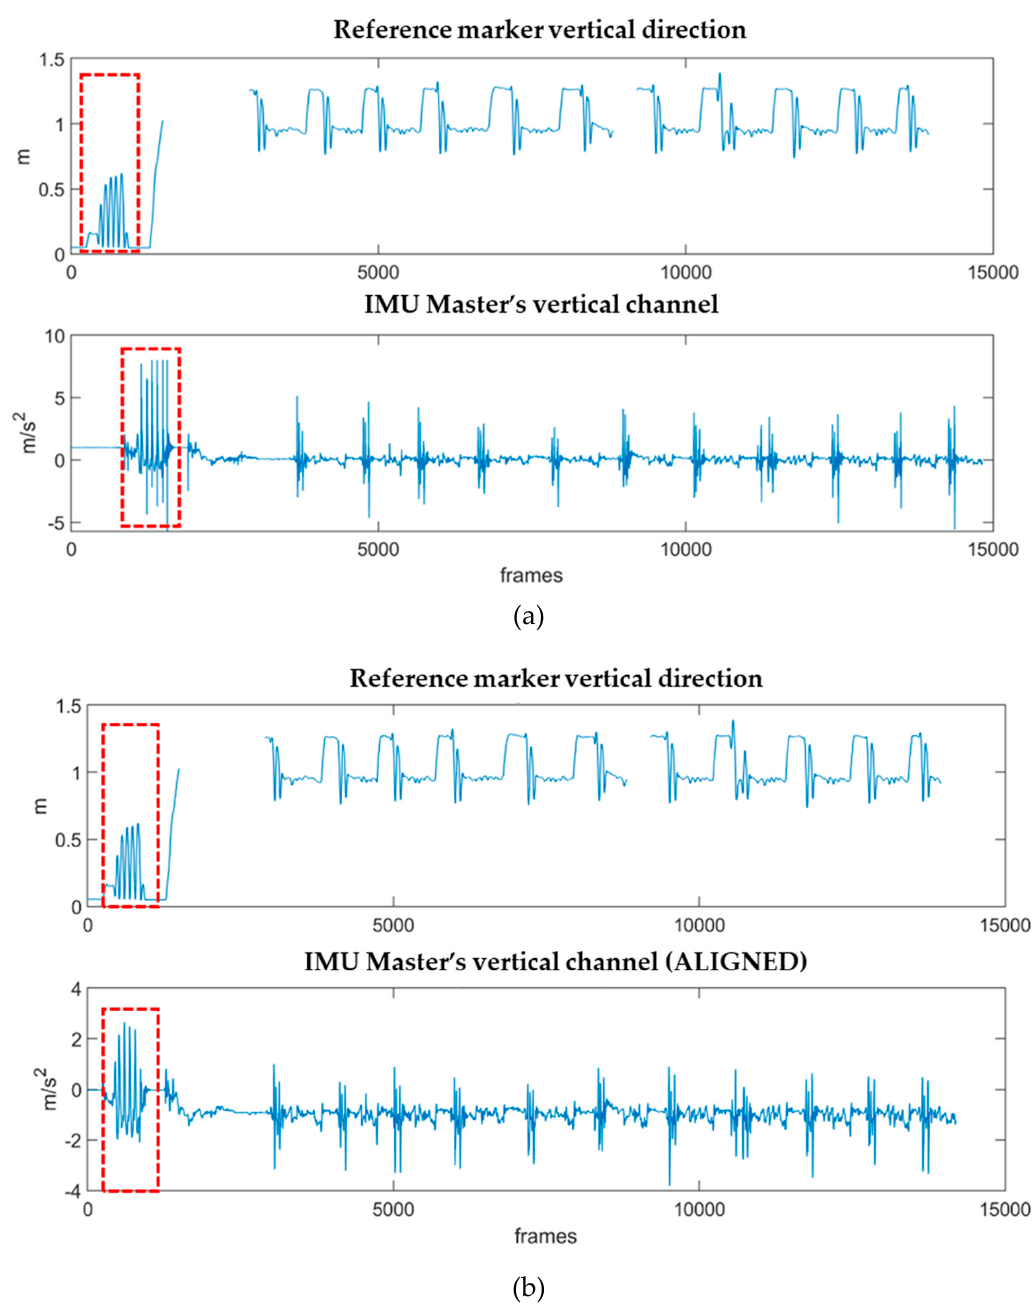
Figure 5. ( a ) Vertical position of the reference marker along the y -axis of the laboratory (vertical, positive upwards) and acceleration data along the z -axis of the master sensor, attached to the reference marker (vertical, positive downwards). The spikes used as synchronization trigger are visible at the very beginning of each signal (red square); ( b ) Aligned signals of reference marker and acceleration of the master by using the delay information coming from the cross-correlation calculation.